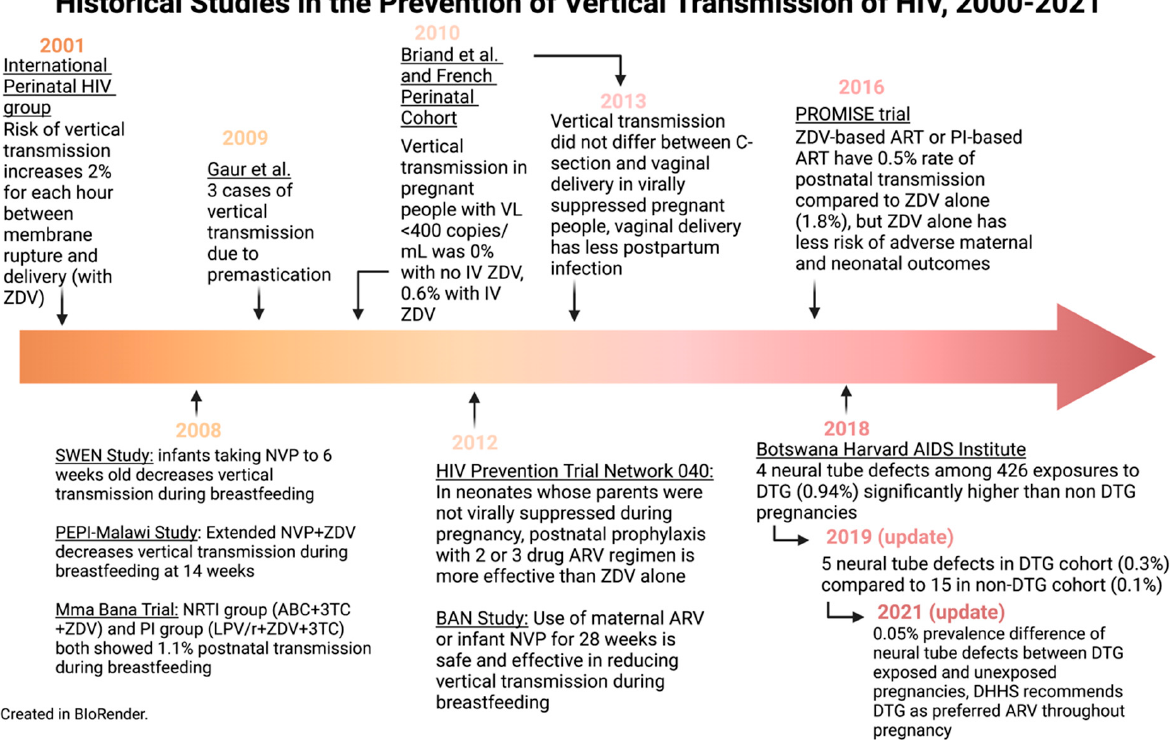
Figure 5. Historical studies in the prevention of vertical transmission of HIV, 2000–2021. Created in BioRender.com.